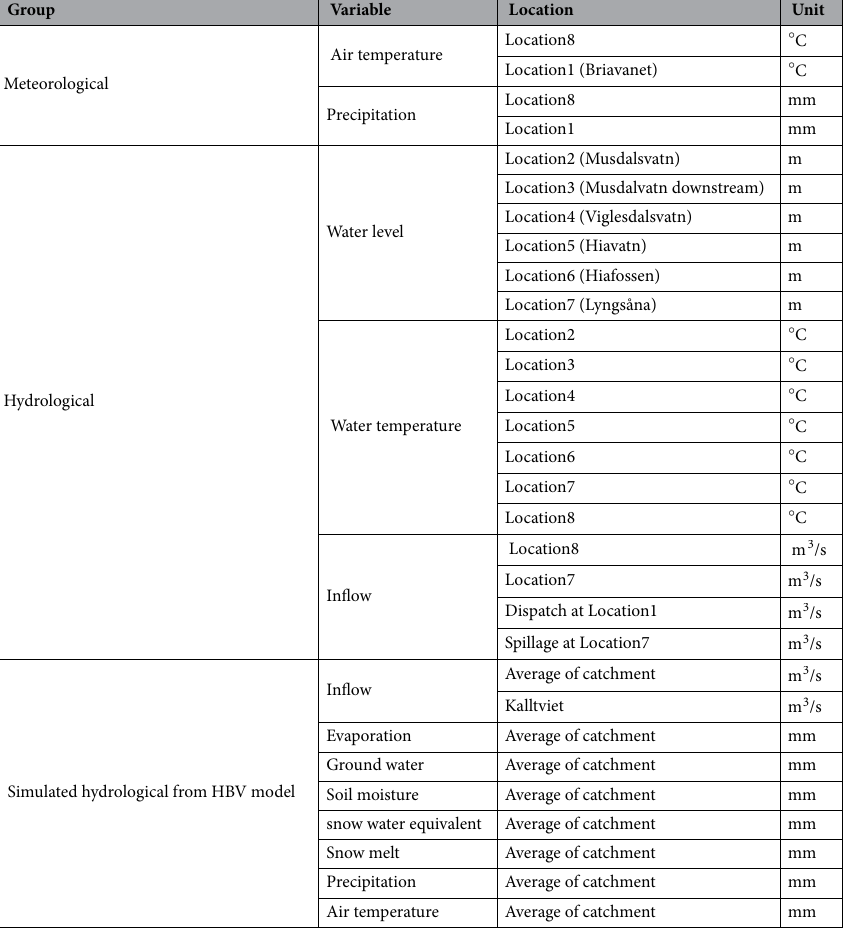
Table 1. Collected